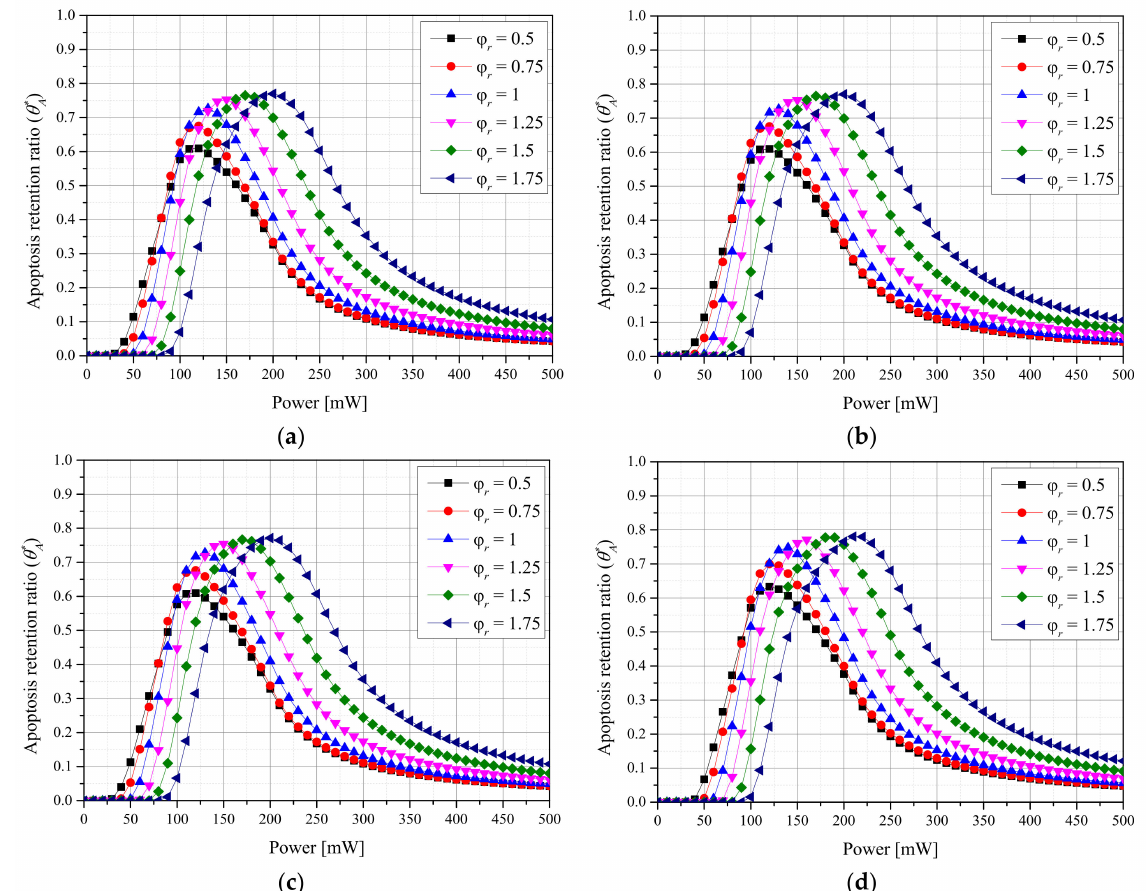
Figure 2. ( a ) f v = 10 − 3 . ( b ) f v = 10 − 4 . ( c ) f v = 10 − 5 . ( d ) f v = 10 − 6 . Apoptosis retention ratio ( θ ∗ different radius ratios ( ϕ r ) (Gaussian